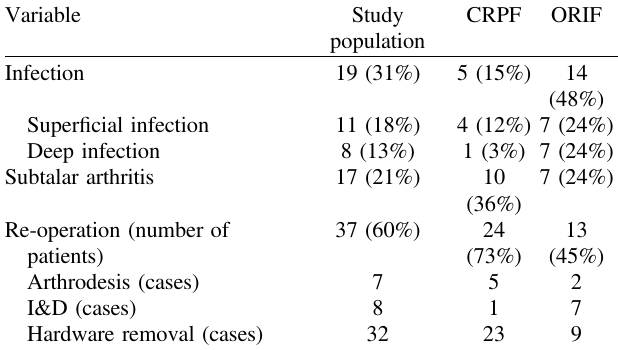
Table 3. Complications, rates of infection, incidence of